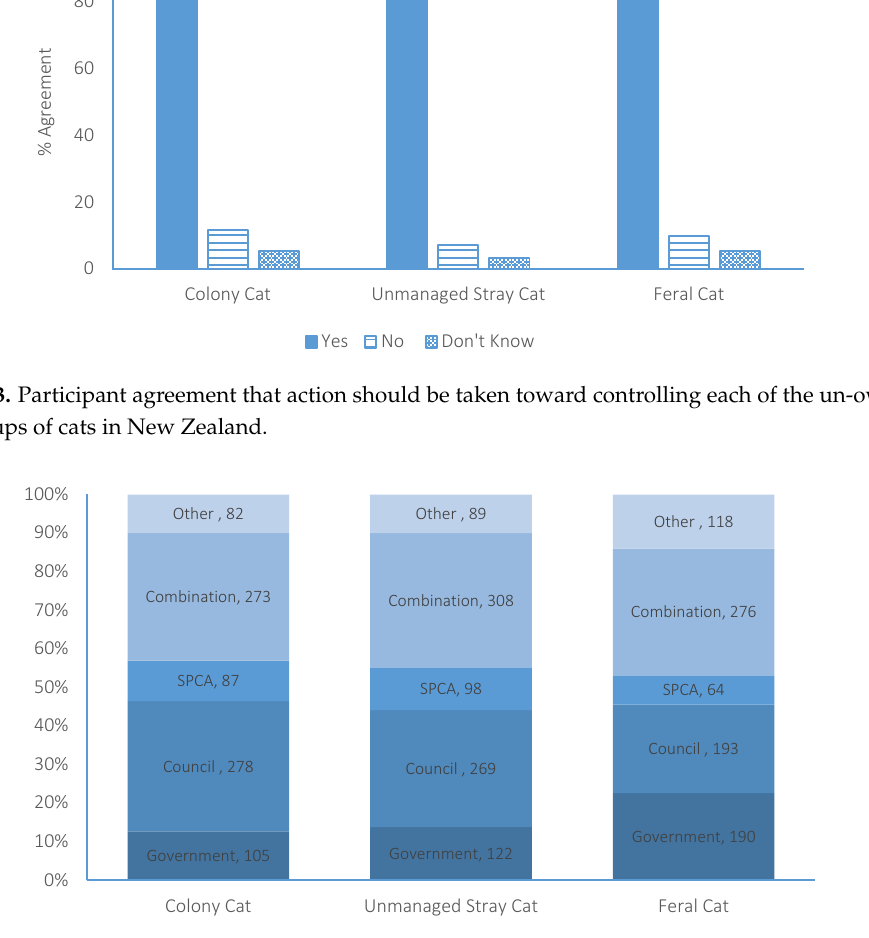
Figure 4. Participant opinion as to which organisation should be responsible for the control of each subgroup of un-owned cats in New Zealand.